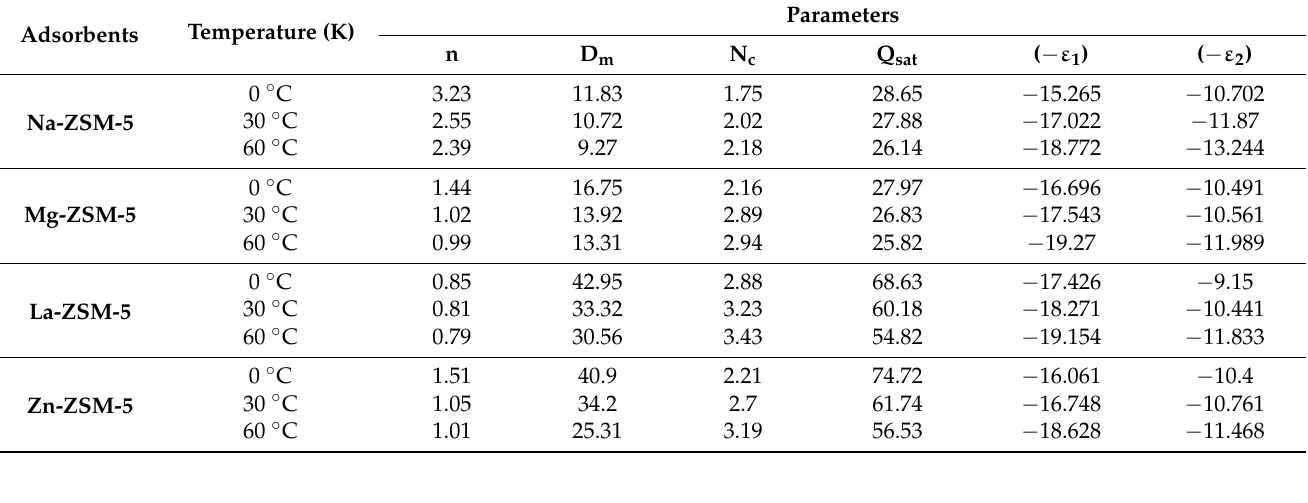
Table 2. Values of the different adjusted parameters according to the multilayer model with satura- tion (M3).